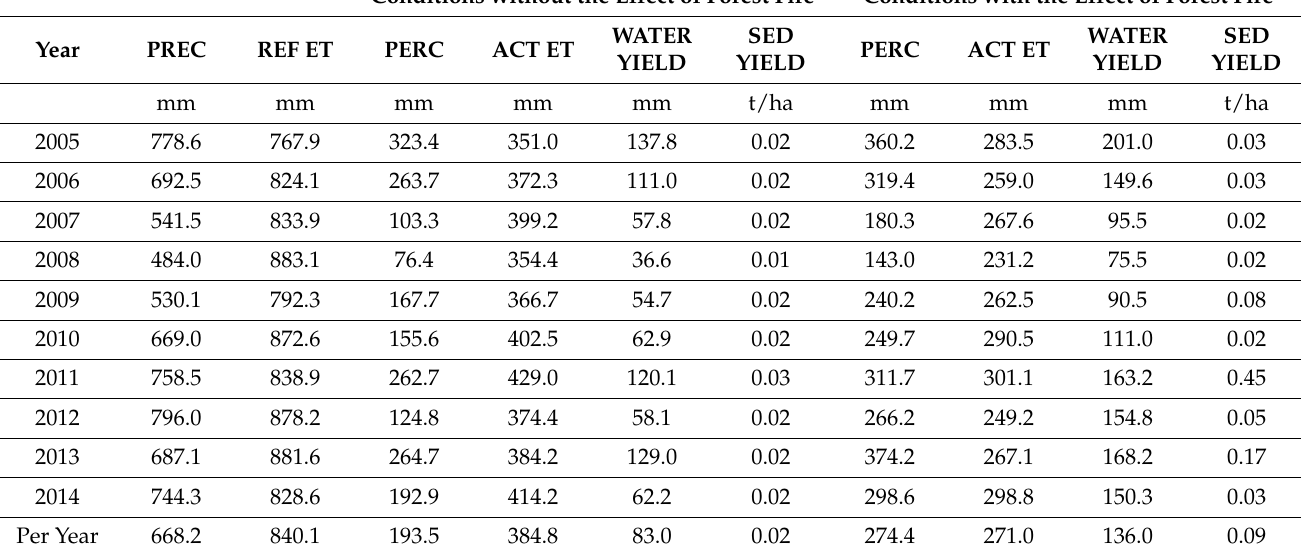
Table 4. Summary of the water balance components at an annual time step based on the model results for the two examined scenarios. PREC: precipitation, REF ET: reference evapotranspiration, PERC: percolation, ACT ET: actual evapotranspiration, SED YIELD: sediment